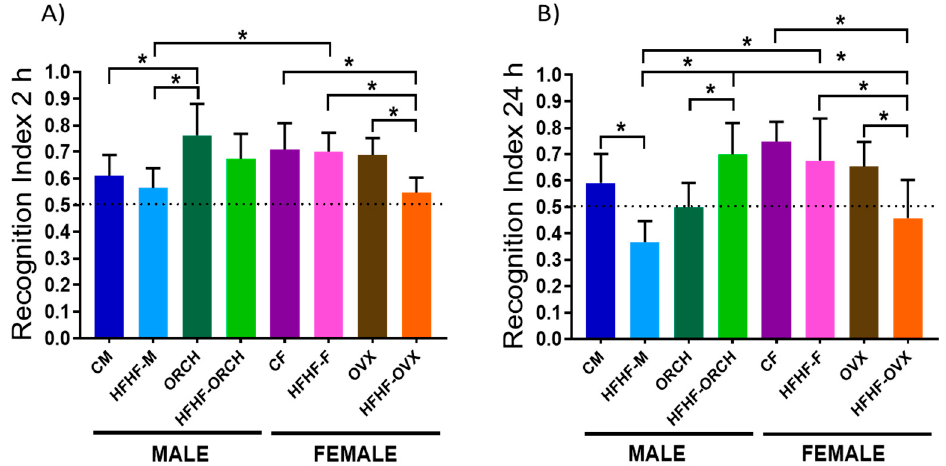
Figure 2. Effect of the HFHD diet in the recognition test of new objects. ( A ) The episodic memory in short time to 2 h is not affected in any of the experimental groups. ( B ) To 24 h, the HFHF-M group has a greater tendency to the familiar object. The dotted line represents that, below 0.5, the rat spent more time with the familiar object, while above 0.5 spent more time with the new object ( n = 10 per group). CM: control males, HFHF-M: metabolic syndrome males, ORCH: males with orchidectomy, HFHF-ORCH: metabolic syndrome males with orchidectomy, CF: control females, HFHF-F: metabolic syndrome females, OVX: females with ovariectomy, and HFHF-OVX: metabolic syndrome females with ovariectomy. The graphs represent the mean ± SD. Evidence of 3-way ANOVA with post hoc Tukey test. * p < 0.05 between the groups. Recognition index 2 h: main effect of diet exposure [F (1, 72) = 10.88, p < 0.01]; sex × hormones interaction [F (1, 72) = 25.65, p < 0.0001]; and diet exposure × hormone interaction [F (1, 72) = 4.280, p < 0.05]. Recognition index 24 h: main effect of diet exposure [F (1, 72) = 6.224, p < 0.05]; main effect of sex [F (1, 72) = 10.29, p < 0.01];